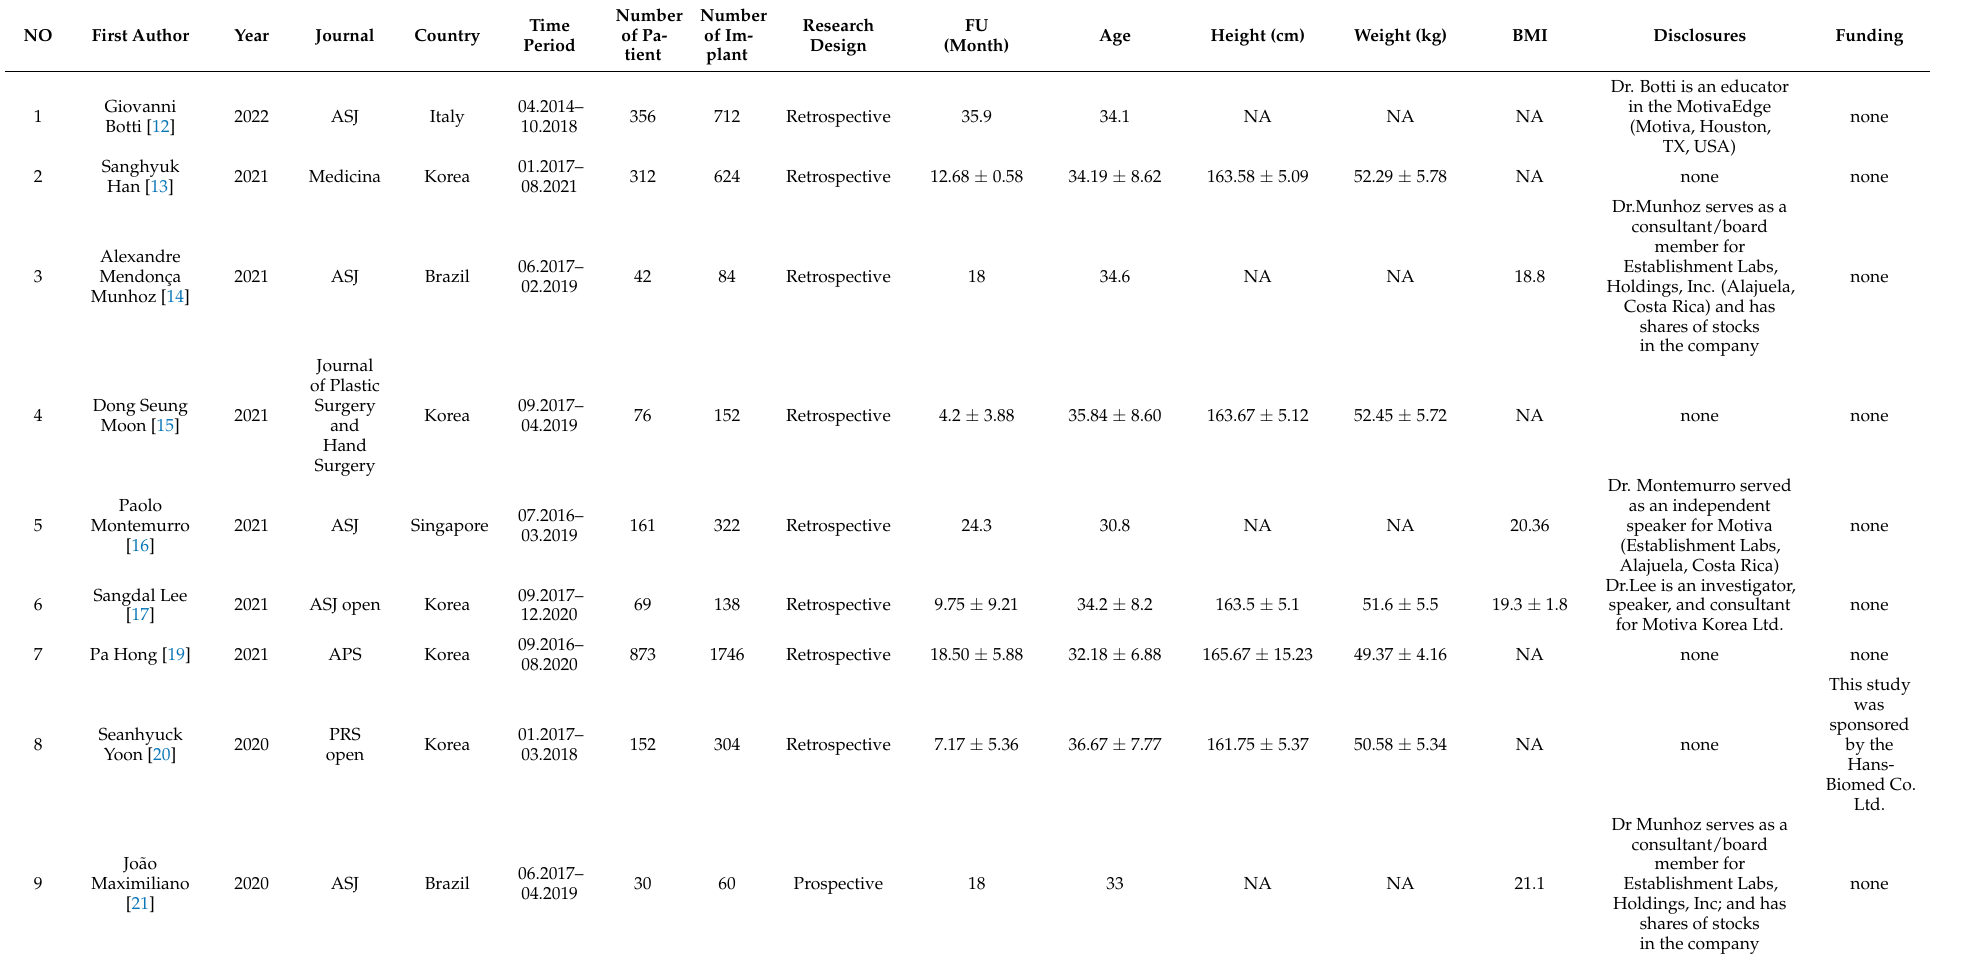
Table 1. The basic characteristics of the included literature and patients’ baseline